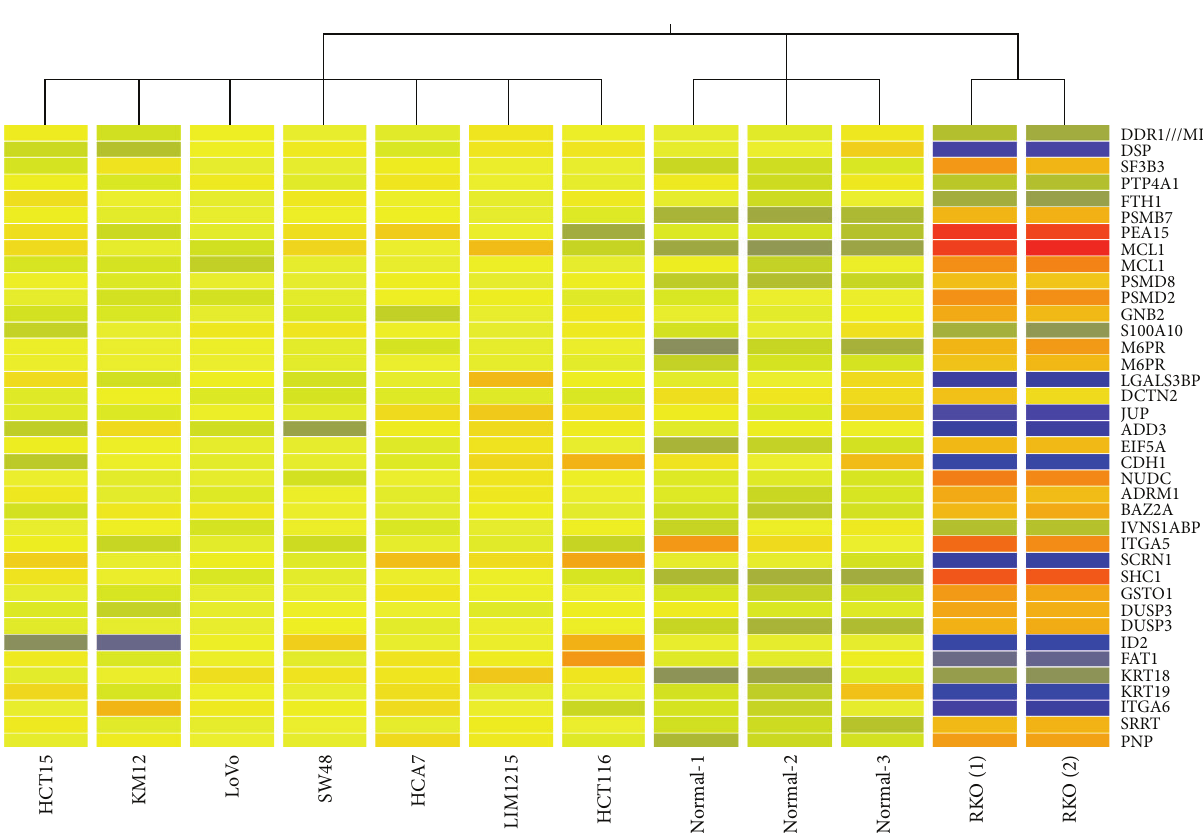
Figure 2: Cluster analysis based on the cDNA expression profiling of all colorectal cancer cell lines and normal colon specimens. The analysis was performed on GeneSpring GX software, version 11.0.2, Agilent